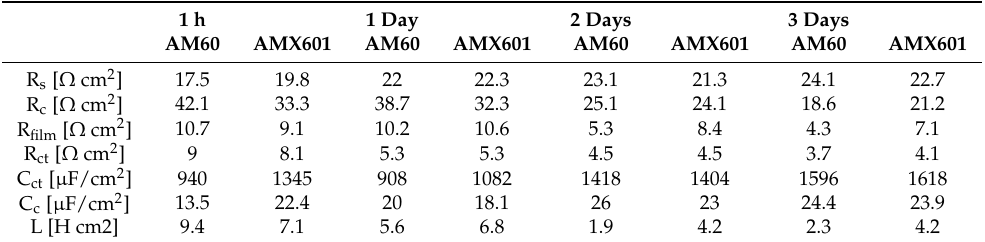
Table 3. The fitting parameters of EIS (electrochemical impedance spectroscopy) for AM60